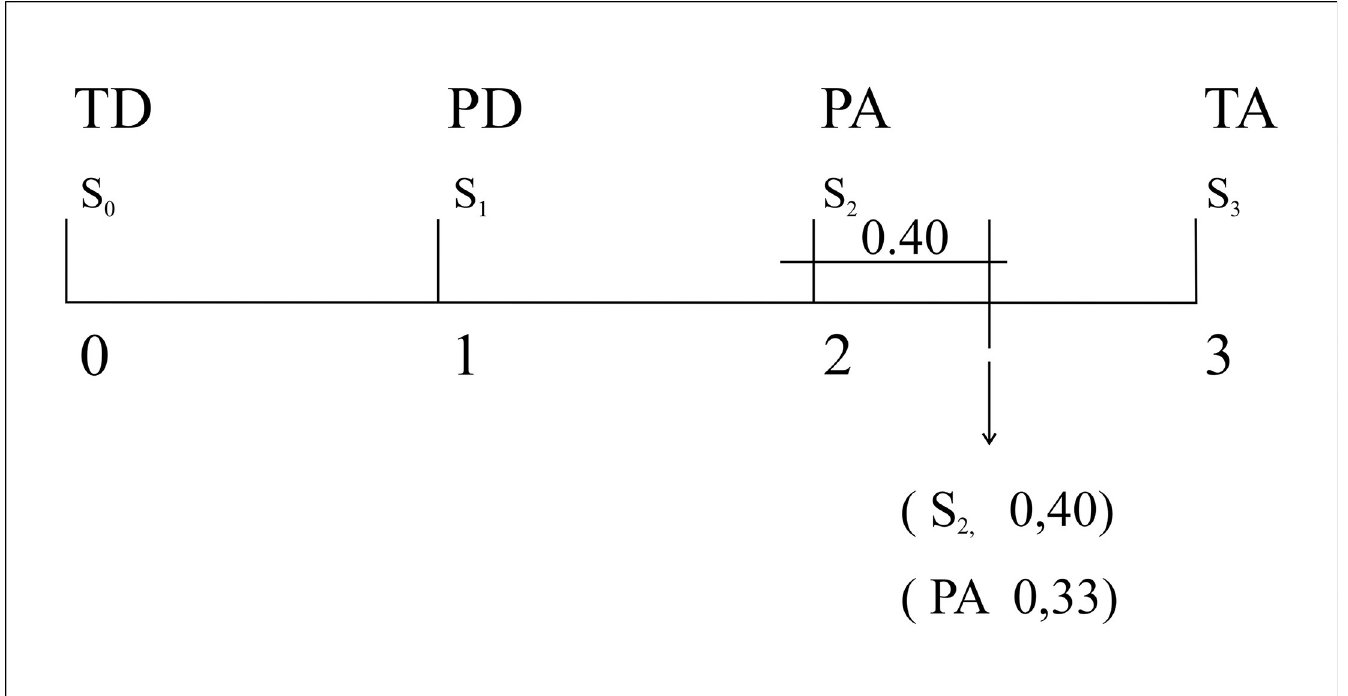
Fig 4. Alternative core-with